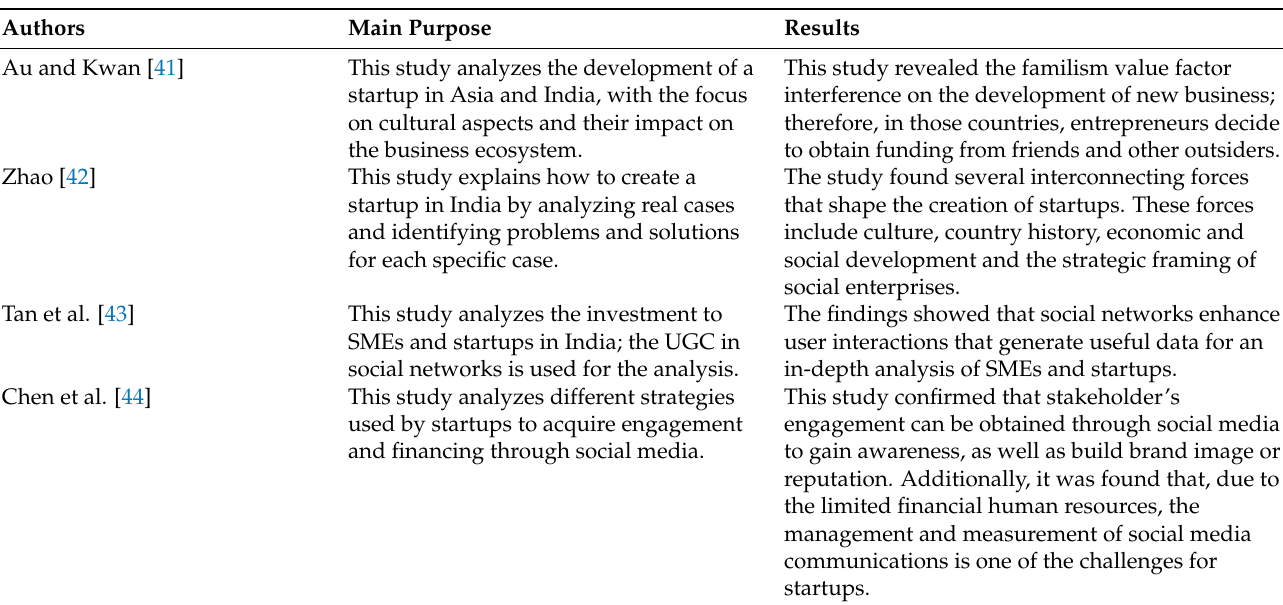
Table 1. Previous studies of the startup ecosystem in